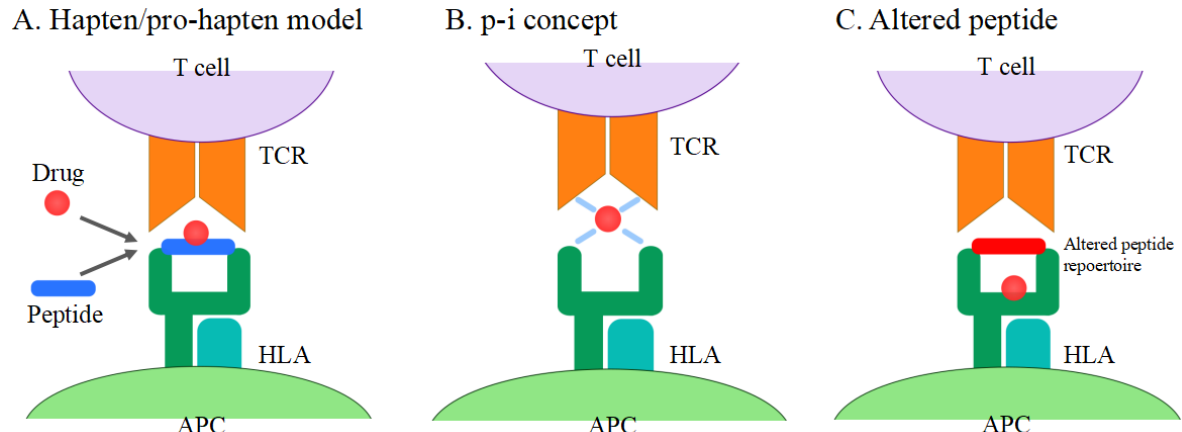
Figure 1. Models of T cell activation in Stevens-Johnson syndrome/toxic epidermal necrolysis. ( A ) Hapten/pro-hapten model: drugs or drug metabolites form a complex with carrier proteins and are presented as haptenated peptides in the peptide-binding groove of the HLA molecules. ( B ) p-i concept: drugs directly bind to HLA and TCR non-covalently. ( C ) Altered peptide model: drugs bind to the peptide-binding groove of HLA, resulting in the alteration of the HLA-binding peptide repertoire. APC, antigen-presenting cell; HLA, human leukocyte antigen; TCR, T cell